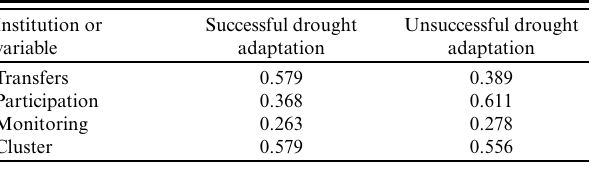
Table 2. Necessity scores for successful and unsuccessful drought